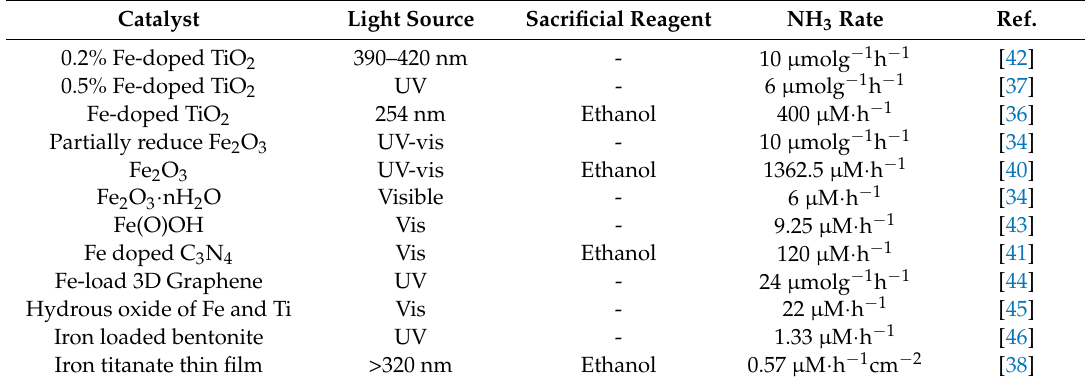
Table 2. Summary of iron active site photocatalysts for the reduction of N 2 to NH 3.